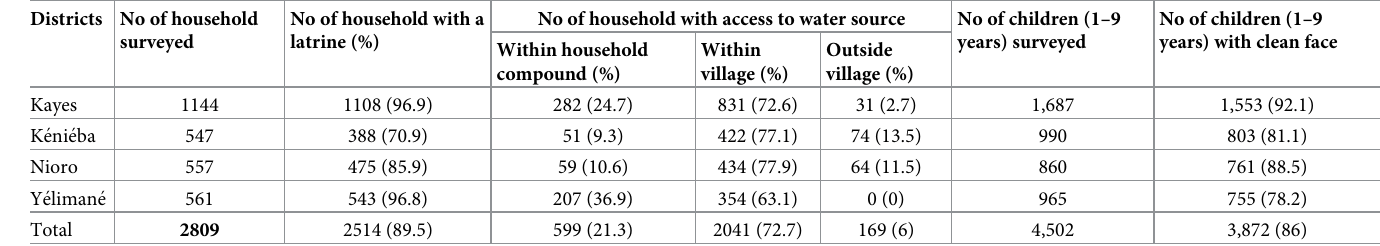
Table 4. Clean faces and access to latrines and water sources in the surveyed clusters in Kayes region in 2015. Districts No of household No of household with a surveyed latrine